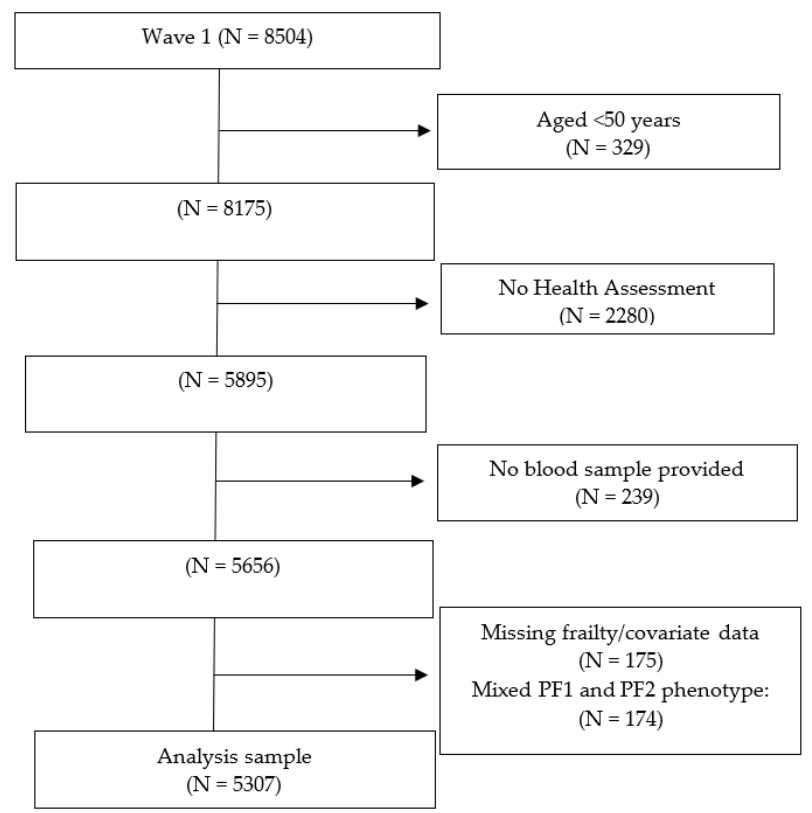
Figure 2. Participants’ flow chart.